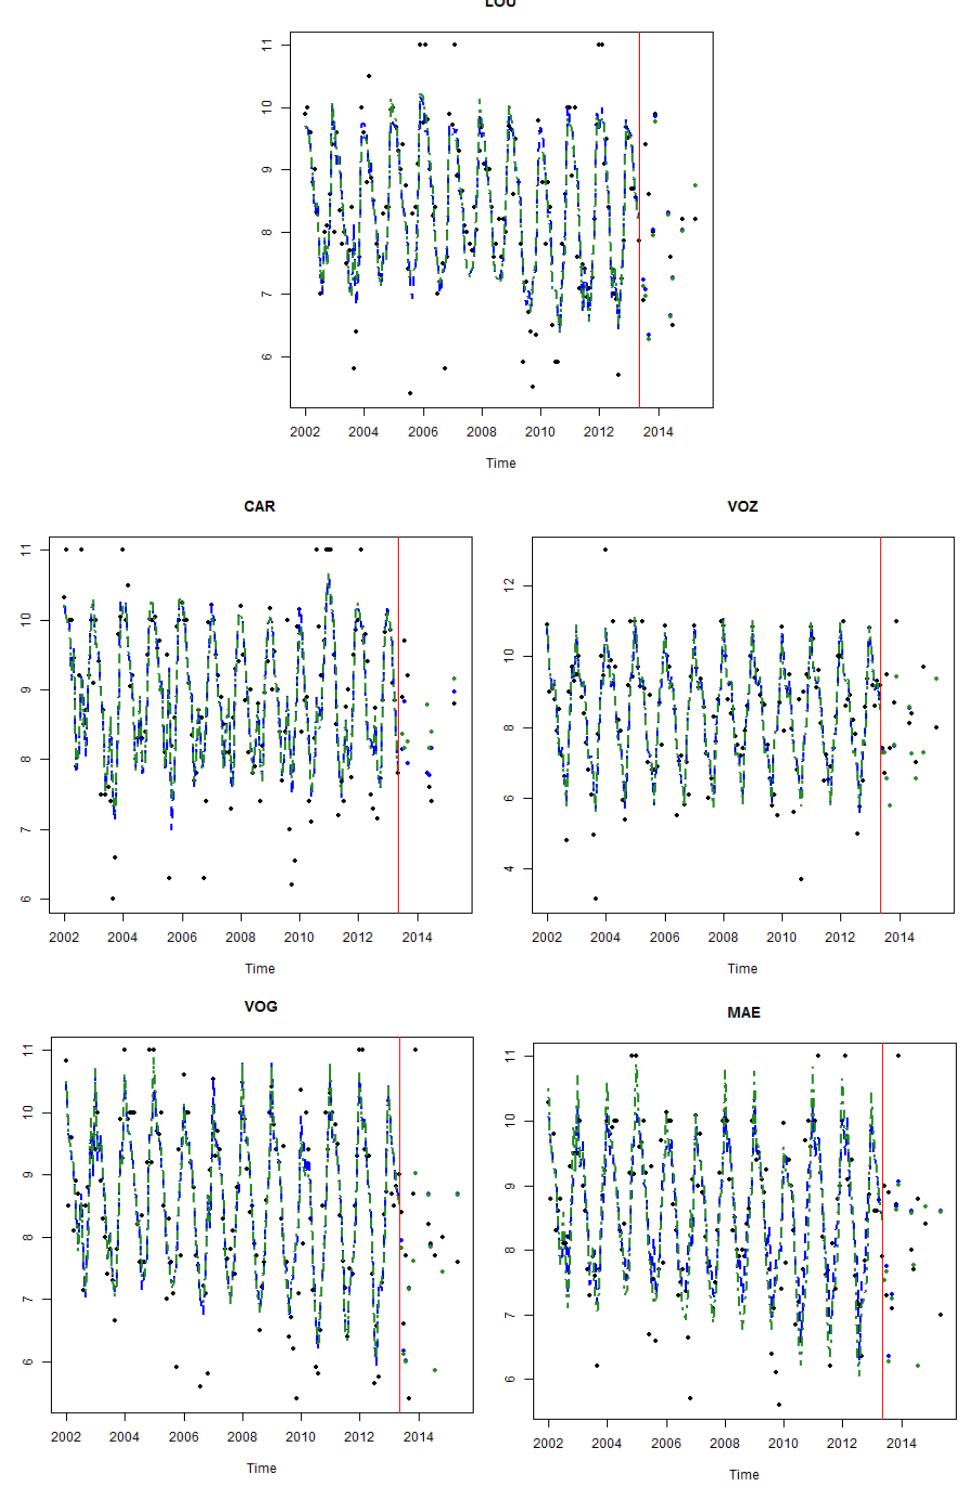
Figure 5. DO concentration values (black) versus fitted values for models MI (blue) and MII (green); h -step forecasts for months after May 2013 (red line) are also